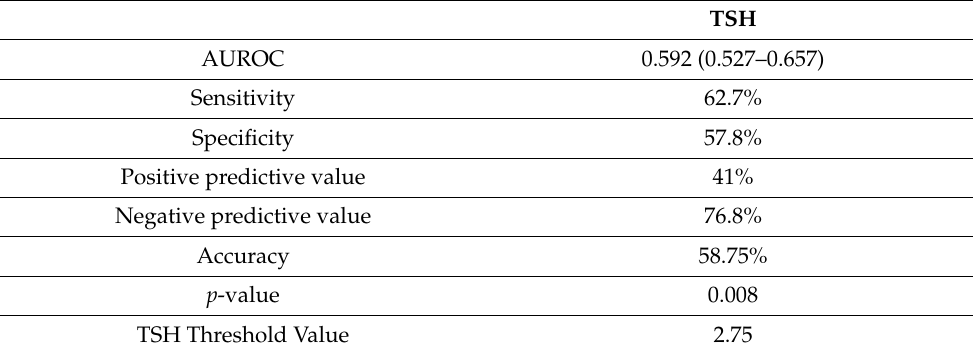
Table 11. ROC curve parameters for TSH in relation to the diagnosis of FSD and the impact on female sexual function.